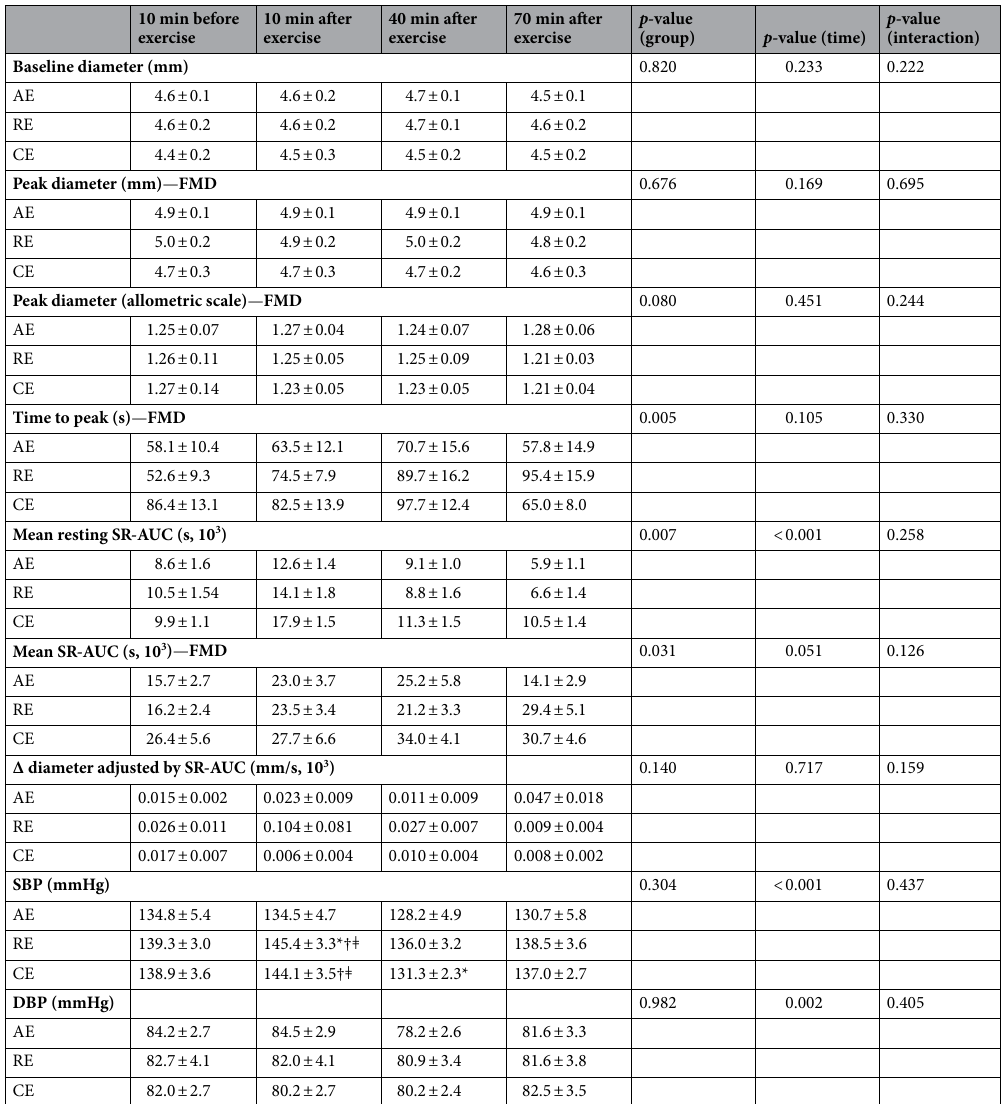
Table 2. Diameter of the brachial artery, time to peak flow-mediated dilation, shear rate and blood pressure in participants with hypertension undergoing three different exercise interventions. Data described as mean ± standard error. AE: aerobic exercise session (n = 11); RE: resistance exercise session (n = 11); CE: combined exercise session (n = 10); Allometric scaling is given by [peak diameter/(baseline diameter) 0,89 ]. Mean SR-AUC: area under the curve of mean resting shear rate (SR) to peak FMD; Δ diameter adjusted by SR-AUC is given by [(peak diameter minus baseline diameter) divided by (mean SR-AUC minus mean resting SR-AUC)] for each individual data. SBP: systolic blood pressure in supine position; DBP: diastolic blood pressure in supine position. GEE with Bonferroni post-hoc test was used. * p < 0.05 versus 10 min before exercise. † p < 0.05 versus 40 min after exercise. ǂ p < 0.05 versus 70 min after